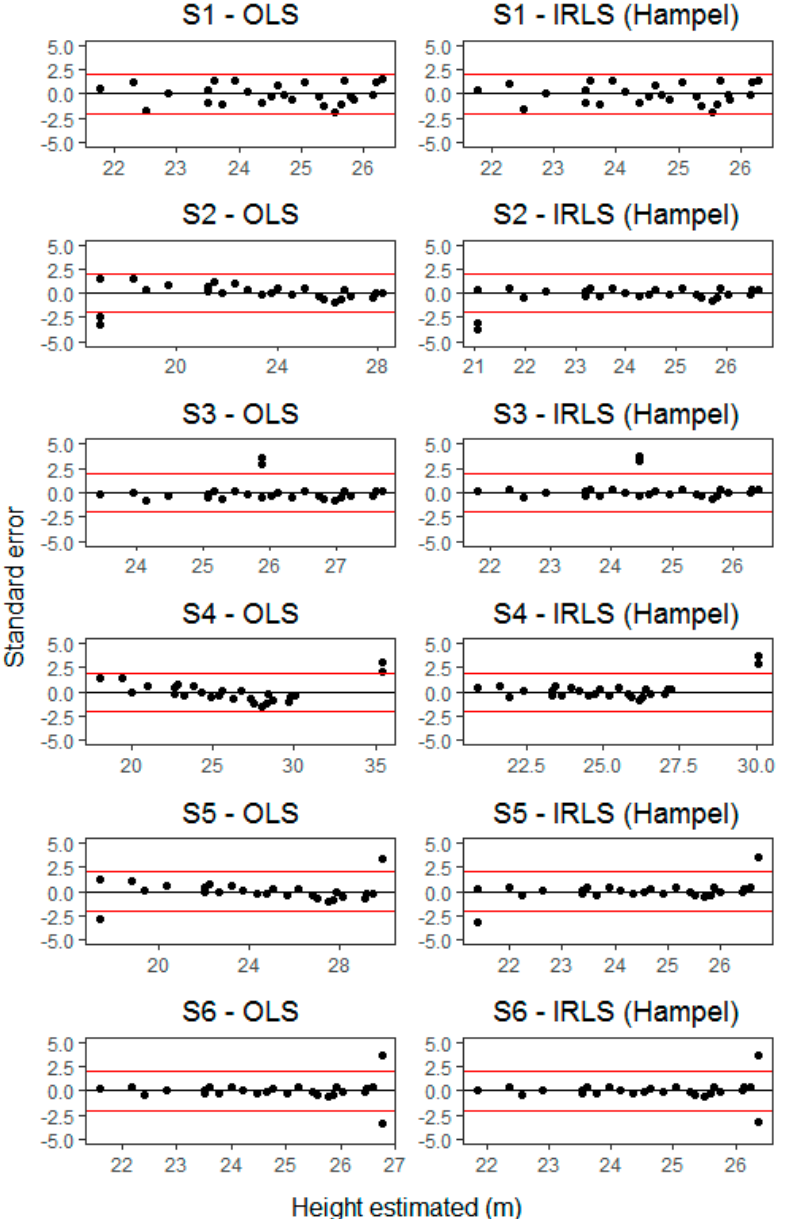
Figure 10. Residuals of Henriksen’s model fitted for Ochroma pyramidale (balsa-tree) aged 4.7 years in Ecuador for six different scenarios (S1 to S6).